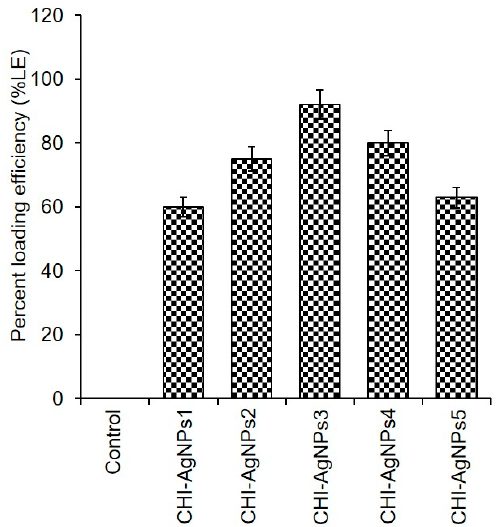
Figure 3. The percent loading efficiency (LE) of AgNPs into the CHI-based conjugate.